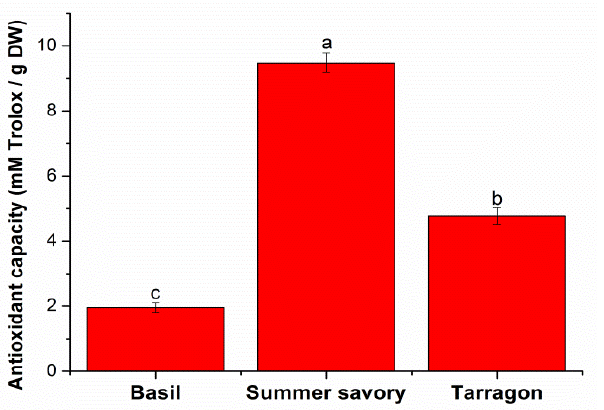
Figure 2. DPPH radical scavenging activity of studied spices. Different letters (a, b, c) mean significant differences between the spices, determined by Tukey’s test ( p < 0.05).